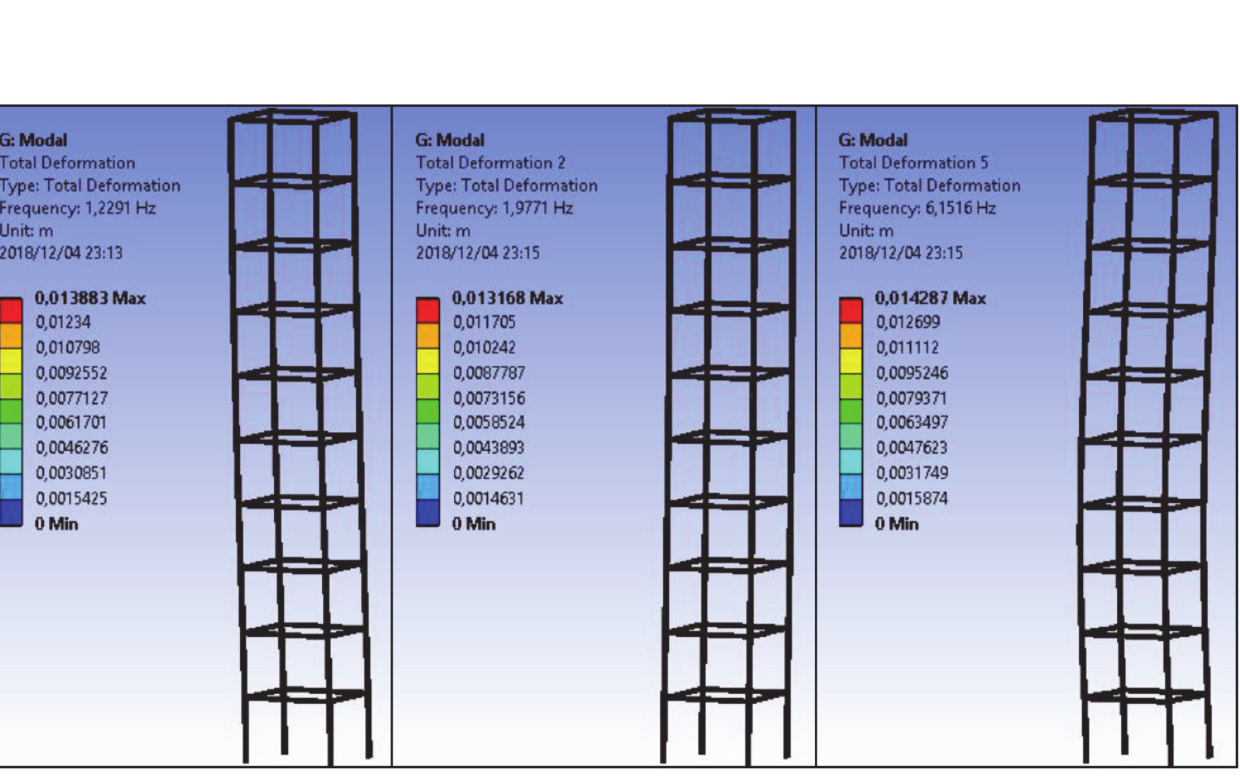
Figure 8: Mode Shapes 1, 2 and 5 of the fixed frame.